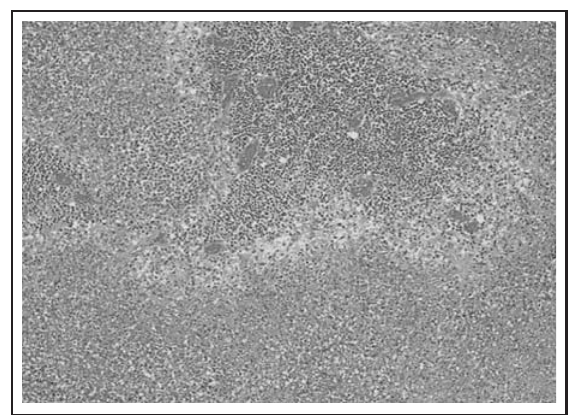
Figure 3. Section showing areas of granuloma with giant cells and necrosis.